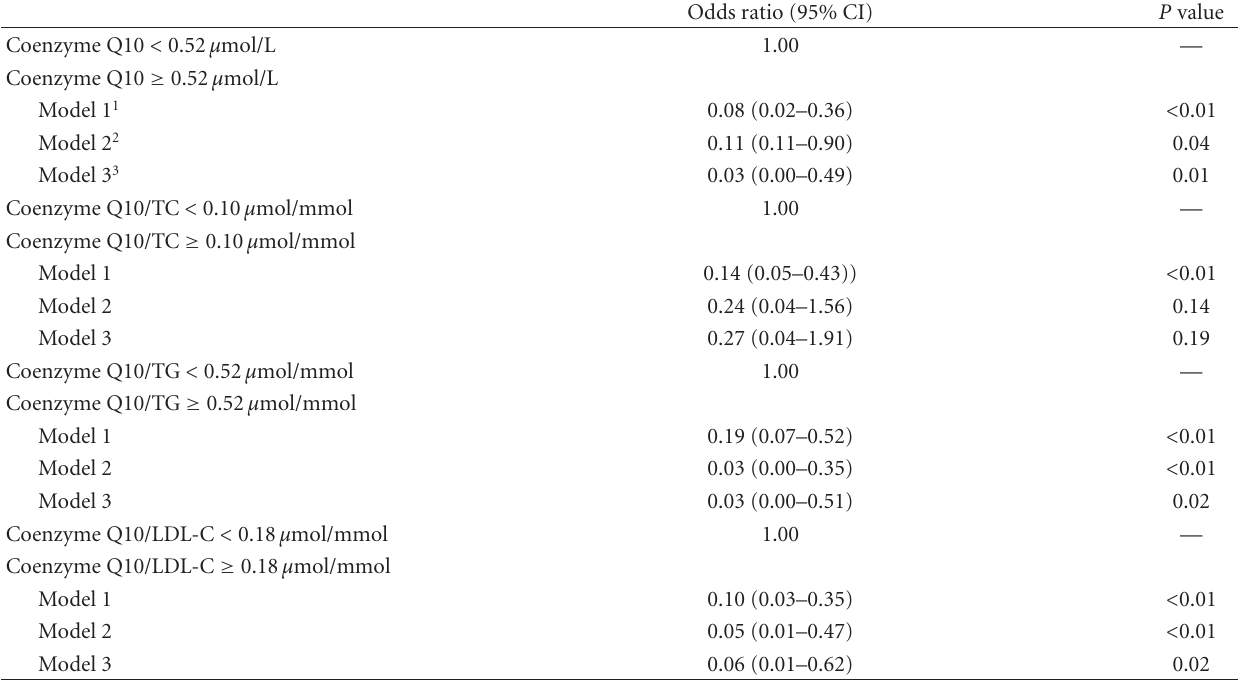
Table 3: The odds ratios of coronary artery disease based on the concentrations of coenzyme Q10 and the ratios of coenzyme Q10 to the lipid